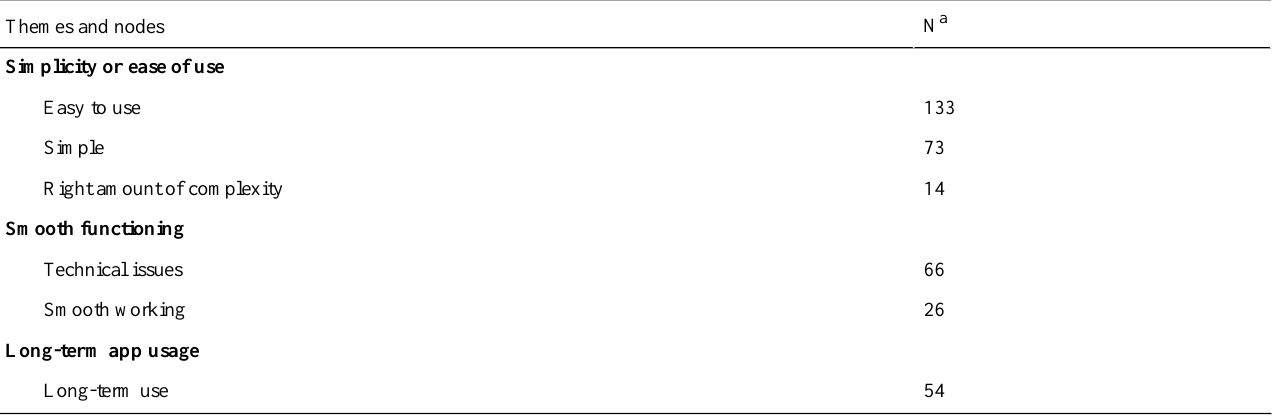
Table 6. The most prominent themes identified through thematic